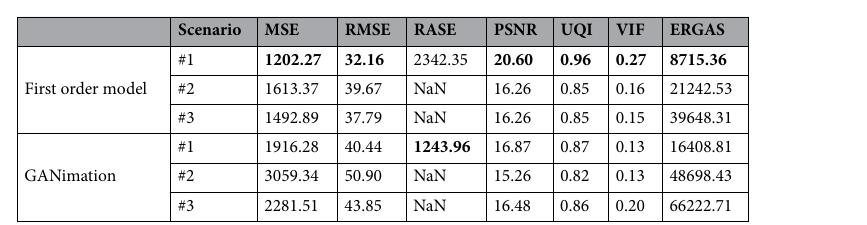
Table 3. Performance evaluation of the expression swap models by the scenario on IQA metrics. Significance values are in